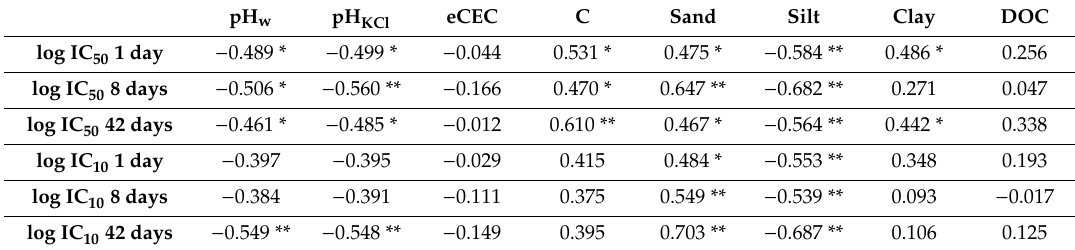
Table 4. Pearson correlation coe ffi cients between properties of the studied soils ( n = 22) and log IC 50 and log IC 10 estimated for chlortetracycline after 1, 8 and 42 incubation days. pH